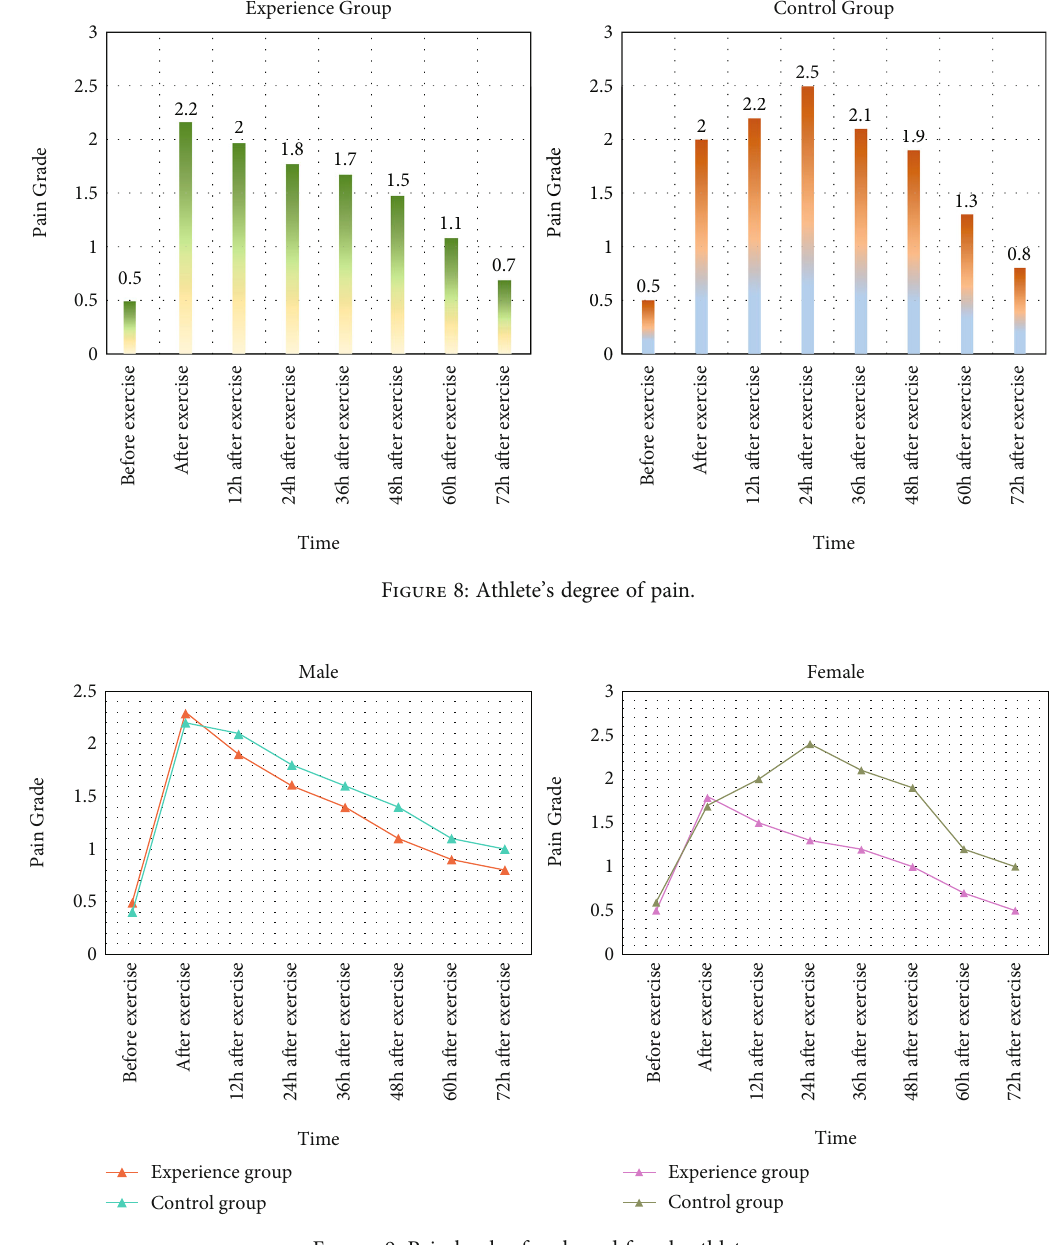
Figure 9: Pain levels of male and female athletes. Table 2: Basic situation of research